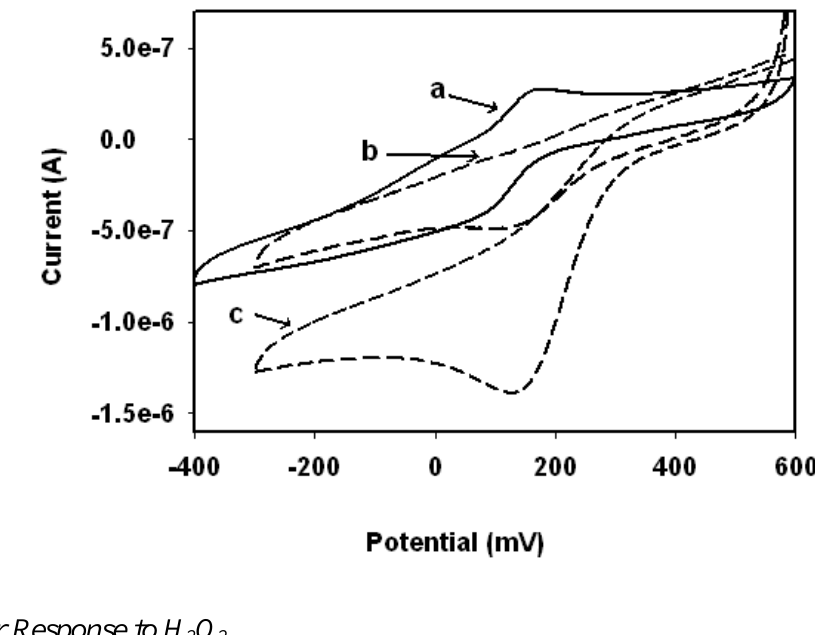
O in 0.1 M phosphate buffer pH 6.5 at 2 2 2